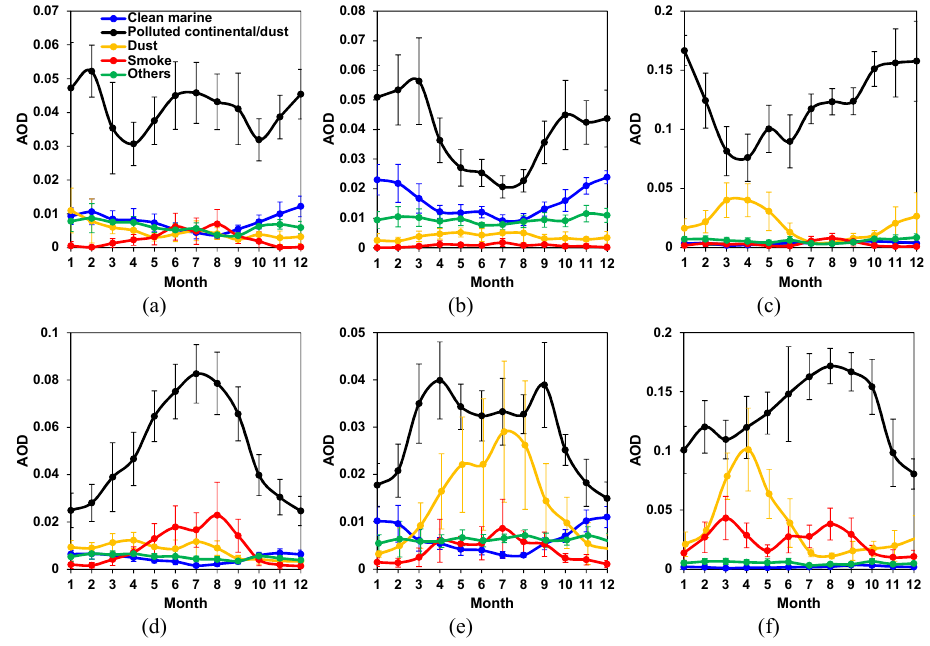
Figure 7. Monthly mean AOD of different aerosol types (a–c) below 800m and (d–f) above 800m observed by CALIPSO during 2007–2016 in (a, d) EUS, (b, e) WEU, and (c, f) ECC. Only clear-sky daytime profiles are used in the averaging to be consistent with the products of MISR and MODIS. The definition of error bars is the same as in Fig. 2. Note the different scales on the y axes of the